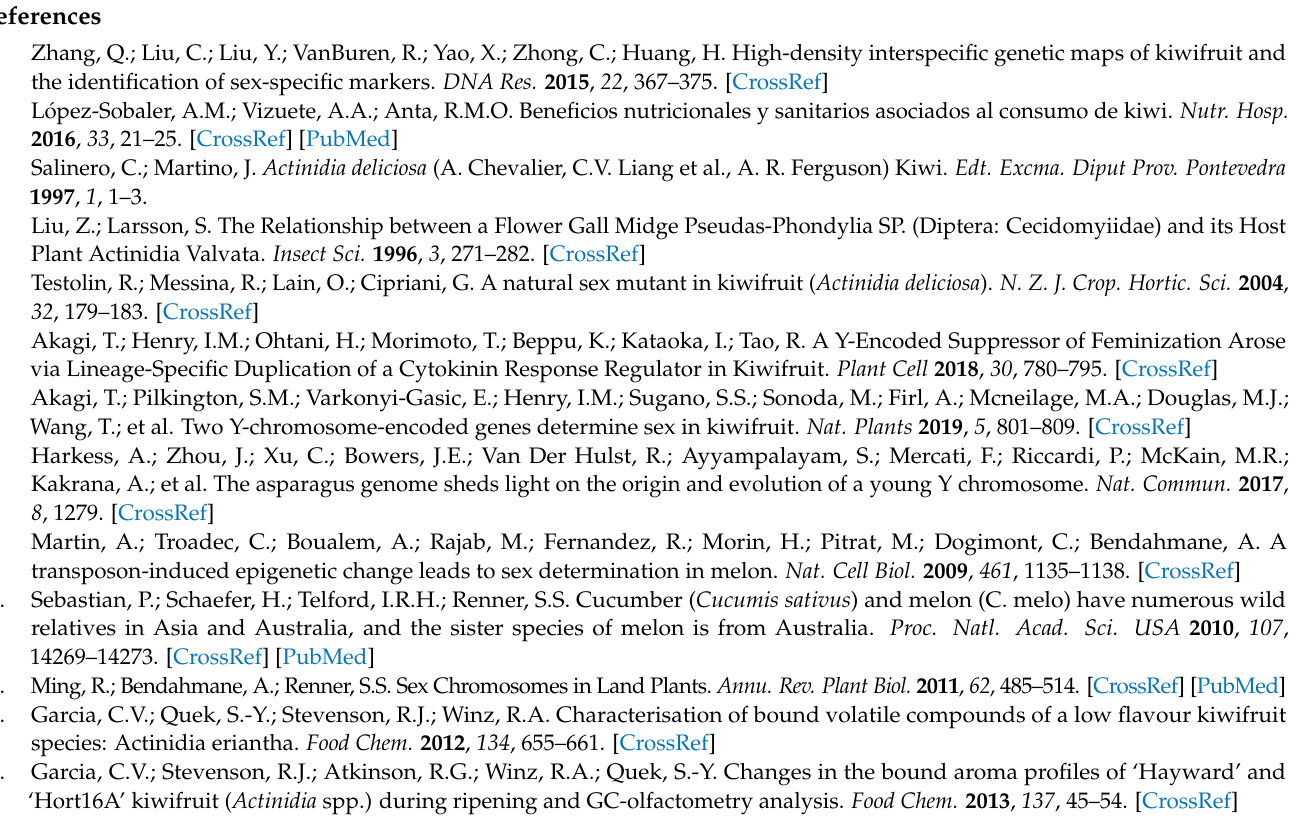
Table S5: Primers used in the reactions of RT-qPCR (xls). Figure S1: Heatmap of gene expression (FPKM) of genes displayed in the protein-protein interaction network expressed in female (H) and male (G × T) flowers using Heatmapper tool by Euclidean distance. The different colours correspond to the transformed value log10. Figure S2: Heatmap of gene expression (FPKM) of genes associated with methyltransferase enzymes expressed in female (H) and male (G × T) flowers using Heatmapper tool by Euclidean distance. The different colours correspond to the transformed value